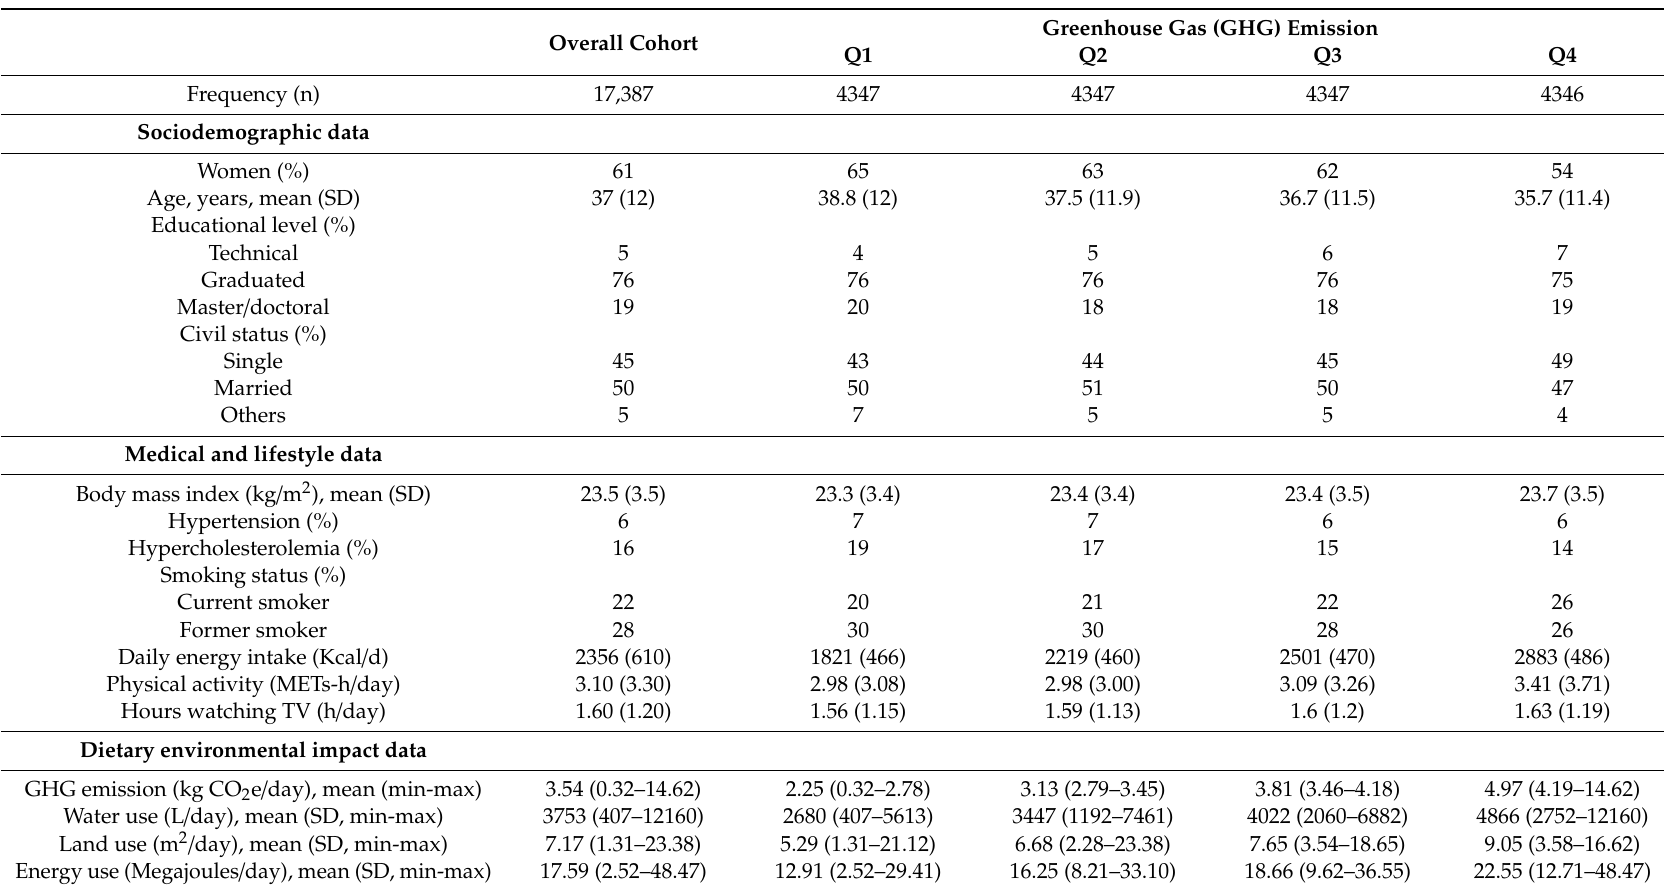
Table 1. Main sociodemographic, medical and lifestyle characteristics of the 17,387 participants of the Seguimiento Universidad de Navarra (SUN) cohort assessed in the current study, 1999–2019.